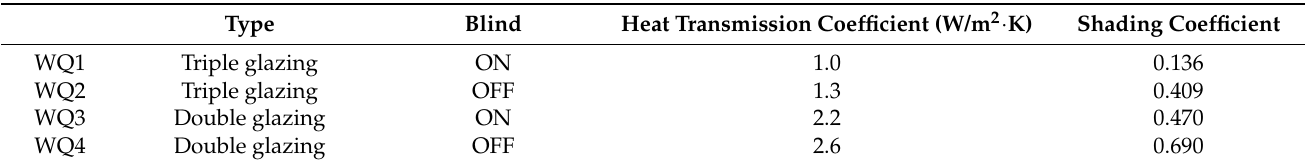
Table 6. Window model. Table 5. Exterior wall model.